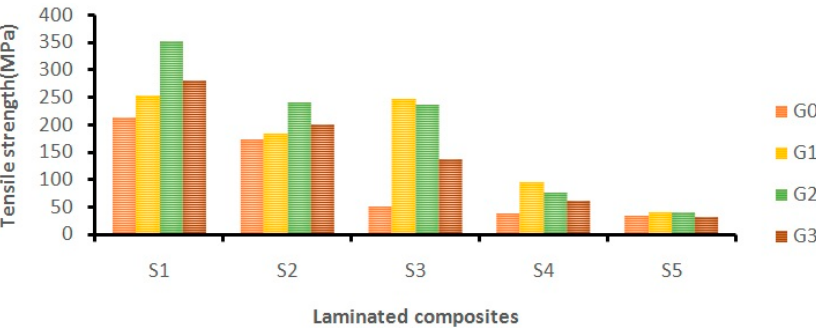
Figure 5. The effect of GNP on the tensile strength of laminated composites. Figure 5. The e ff ect of GNP on the tensile strength of laminated composites.